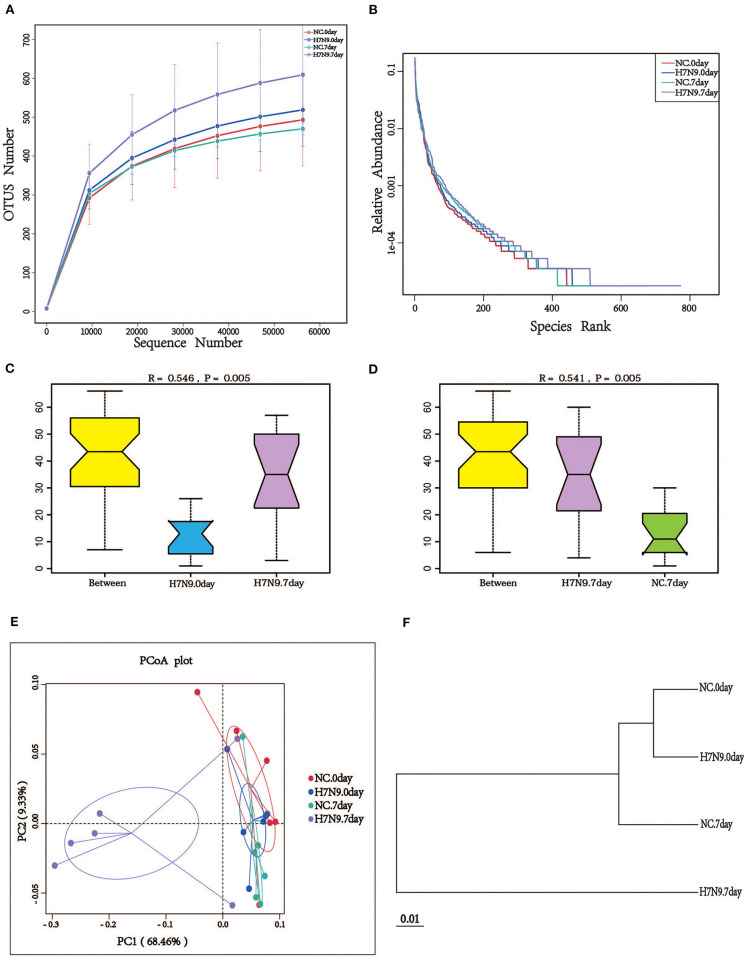
H7N9 influenza virus infection significantly alters the composition of mouse gut microbiota. (A) The rarefaction curves; the abscissa is the number of sequencing samples randomly extracted from a sample, and the ordinate is the number of OTUs that can be constructed based on the sequencing counts. (B) The ranks of abundance curves; the abscissa is the serial number sorted by OTU abundance, and the ordinate is the relative abundance of the corresponding OTUs. The ANOSIM analysis between (C) the H7N9.0 group and the H7N9.7 group, and (D) the NC.7 group and the H7N9.7 group; the ordinate is the rank of the distance between the samples and the abscissa, which is the result from the two groups, and the other two are the results in the respective groups. (E) The PCoA plot based on the weighted UniFrac distances of the 16S rRNA genes. (F) UPGMA tree based on the weighted UniFrac distance matrix.